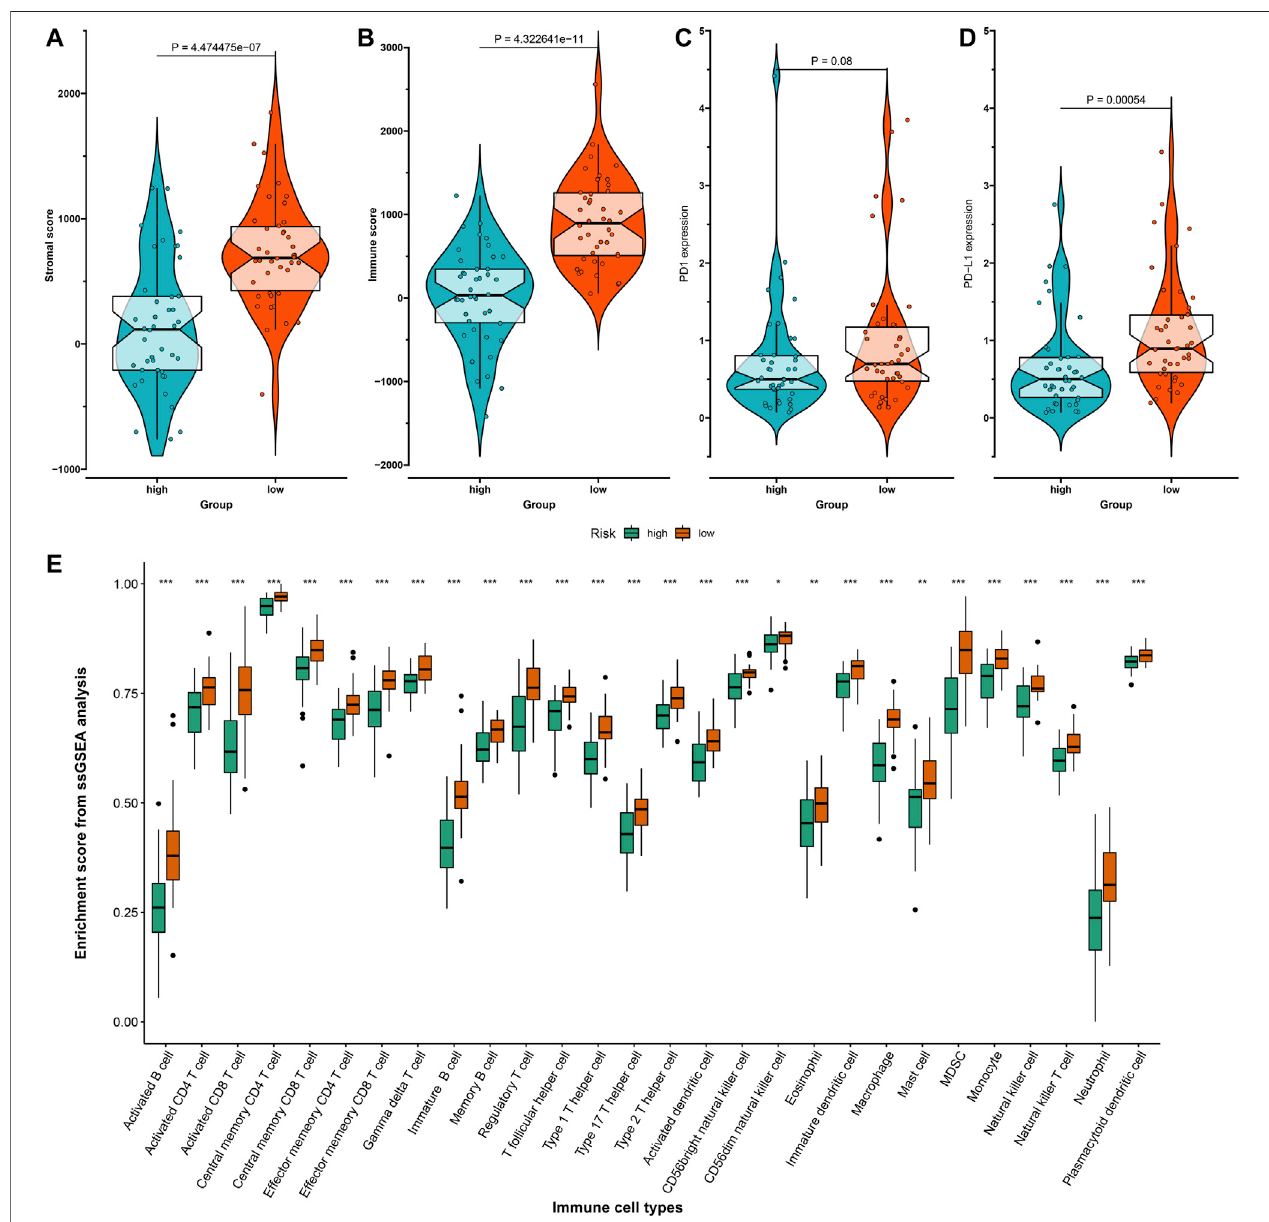
FIGURE5| Associationsbetweenriskscoresand tumor immune microenvironment ofosteosarcoma in theTARGET dataset. (A,B) Thedistributionof (A) stromal scores and (B) immune scores in high- and low-risk osteosarcoma samples with the Estimation of Stromal and Immune Cells in Malignant Tumor Tissues Using Expression Data (ESTIMATE) algorithm. (C,D) The distribution of (C) programmed death-1 (PD-1) and (D) programmed death-ligand 1 (PD-L1) expression in high- and low-risk osteosarcoma samples. (E) The relative in fi ltration levels of immune cells in high- and low-risk groups with the single-sample gene set enrichment analysis (ssGSEA) algorithm. * p < 0.05; ** p < 0.01; *** p <